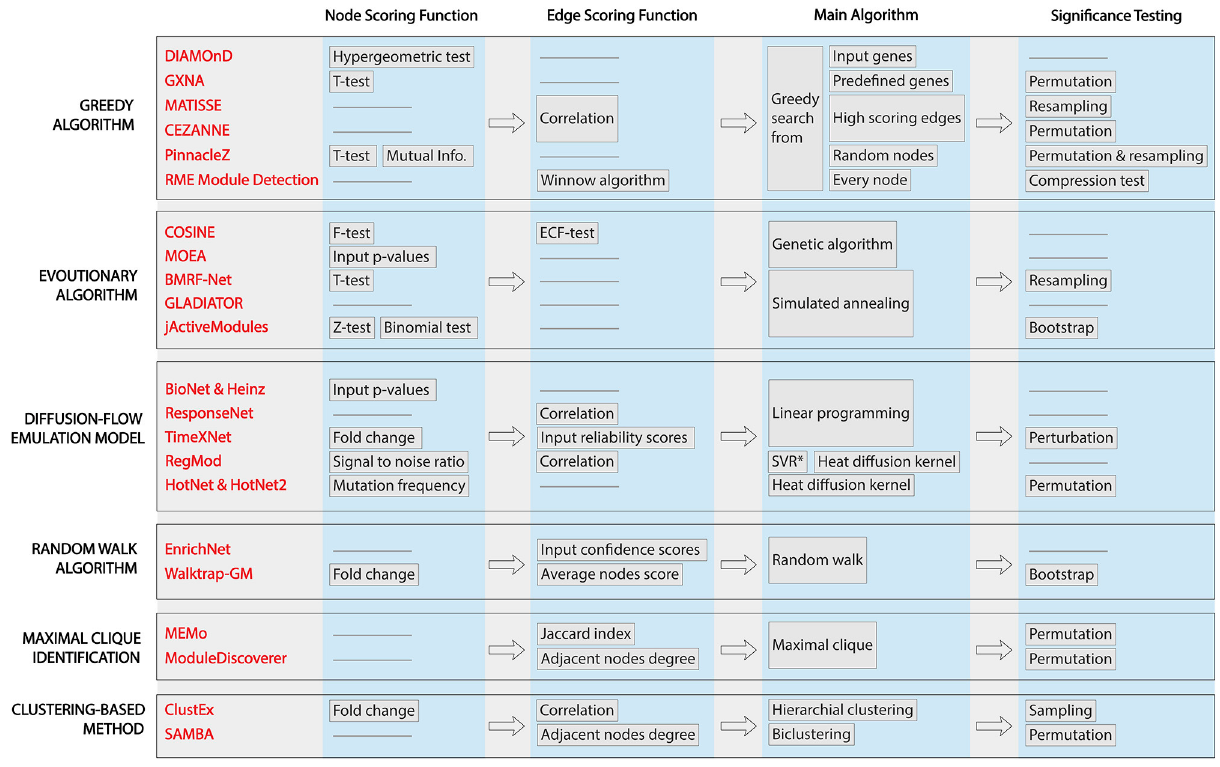
FIGURE 2 | Workflows of active module identification approaches. The figure highlights the key characteristics and key differences between each method. From left to right are the techniques applied in each approach: (i) node scoring, (ii) edge scoring, (iii) algorithm used to construct the subnetworks, and (iv) statistical test for assessing the significance of the identified active subnetworks. We note that GLADIATOR does not score nodes nor edges but uses Jaccard Index between input gene sets (of different diseases) as the objective for its simulated annealing